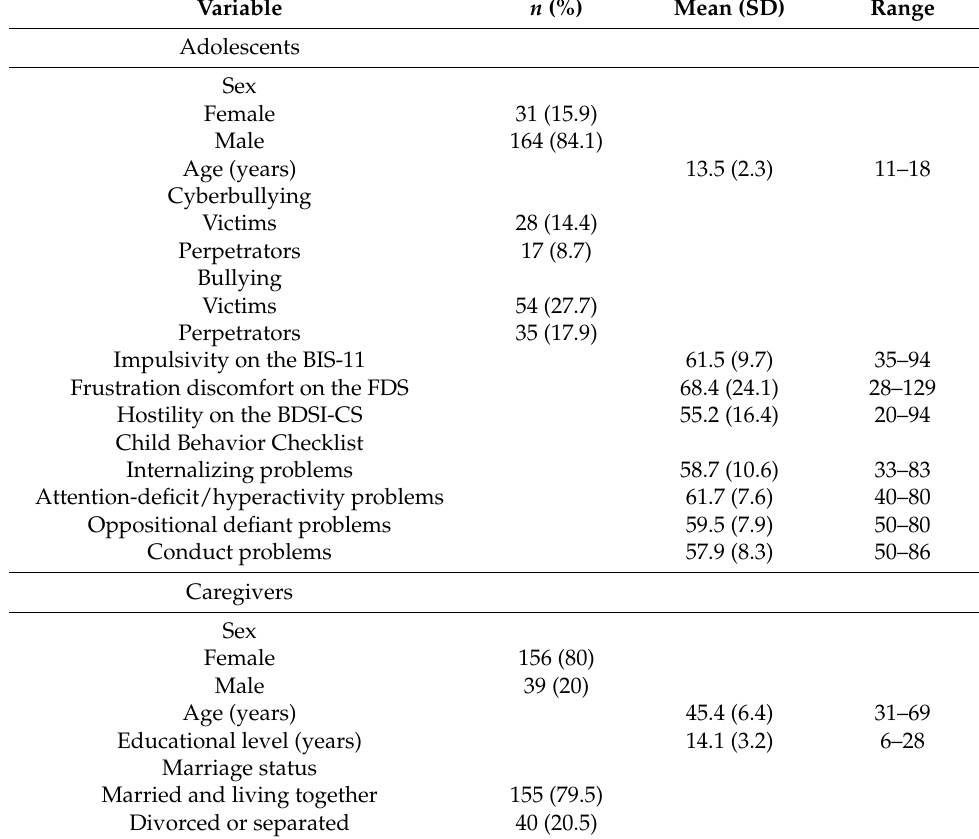
Table 1. Demographic characteristics, bullying involvement, impulsivity, frustration intolerance, hostility, and behavioral problems (N =